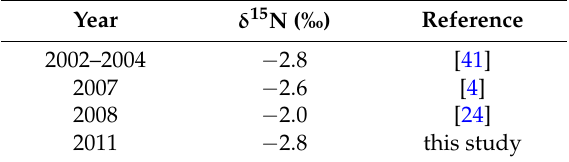
Table 1. Average nitrogen contents and isotopic composition of jack pine needles in the AOSR.